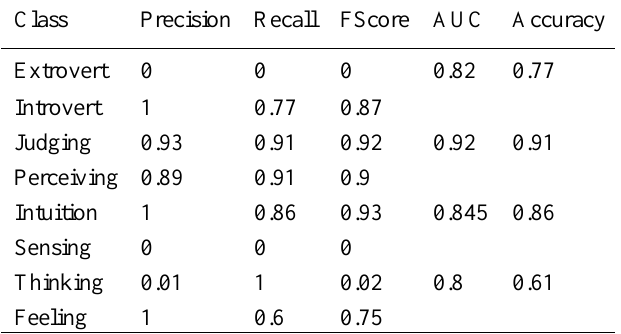
Random Forest result with feature selection